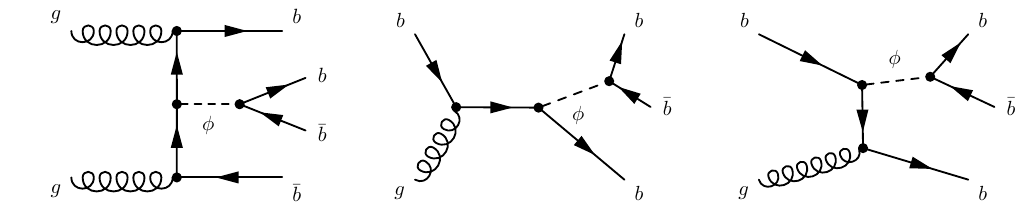
Figure 1 . Example Feynman diagrams for the signal